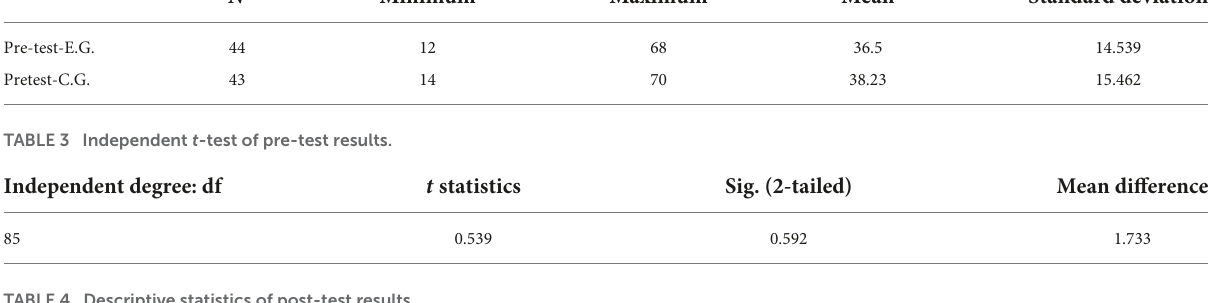
TABLE 4 Descriptive statistics of post-test results.